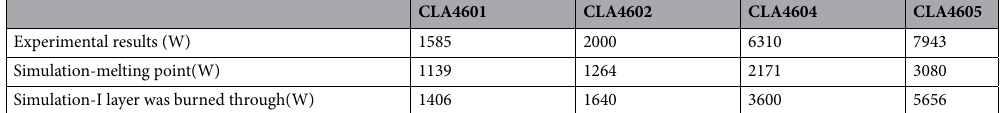
Table 2. Simulation and experimental results for the CLA4601, CLA4602, CLA4604 and CLA4605 silicon limiters.